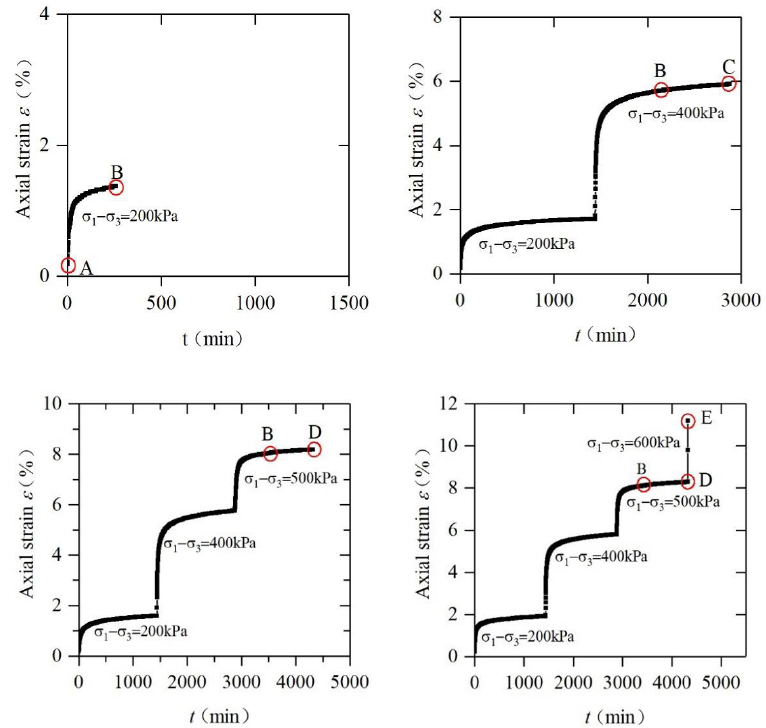
Figure 4. Creep curve of Yan’an loess .